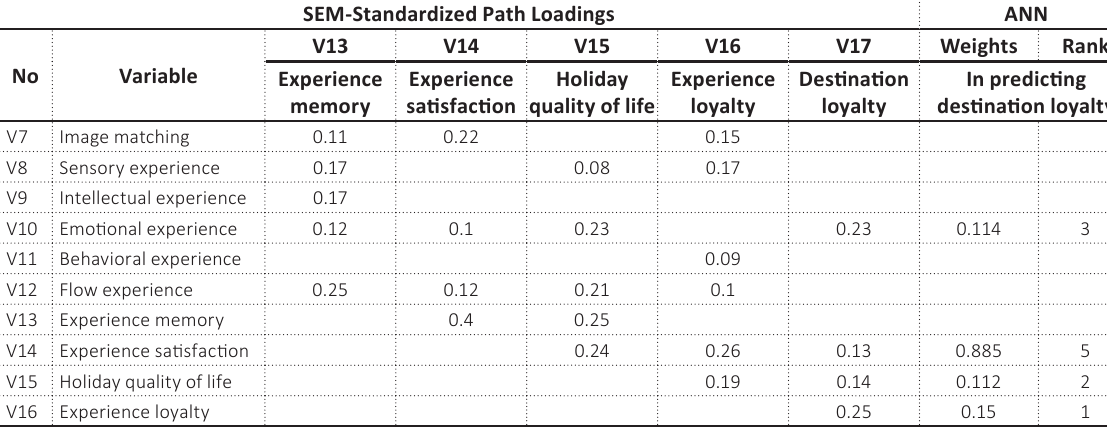
Table 6 (cont.). Standardized path loadings of the hypotheses